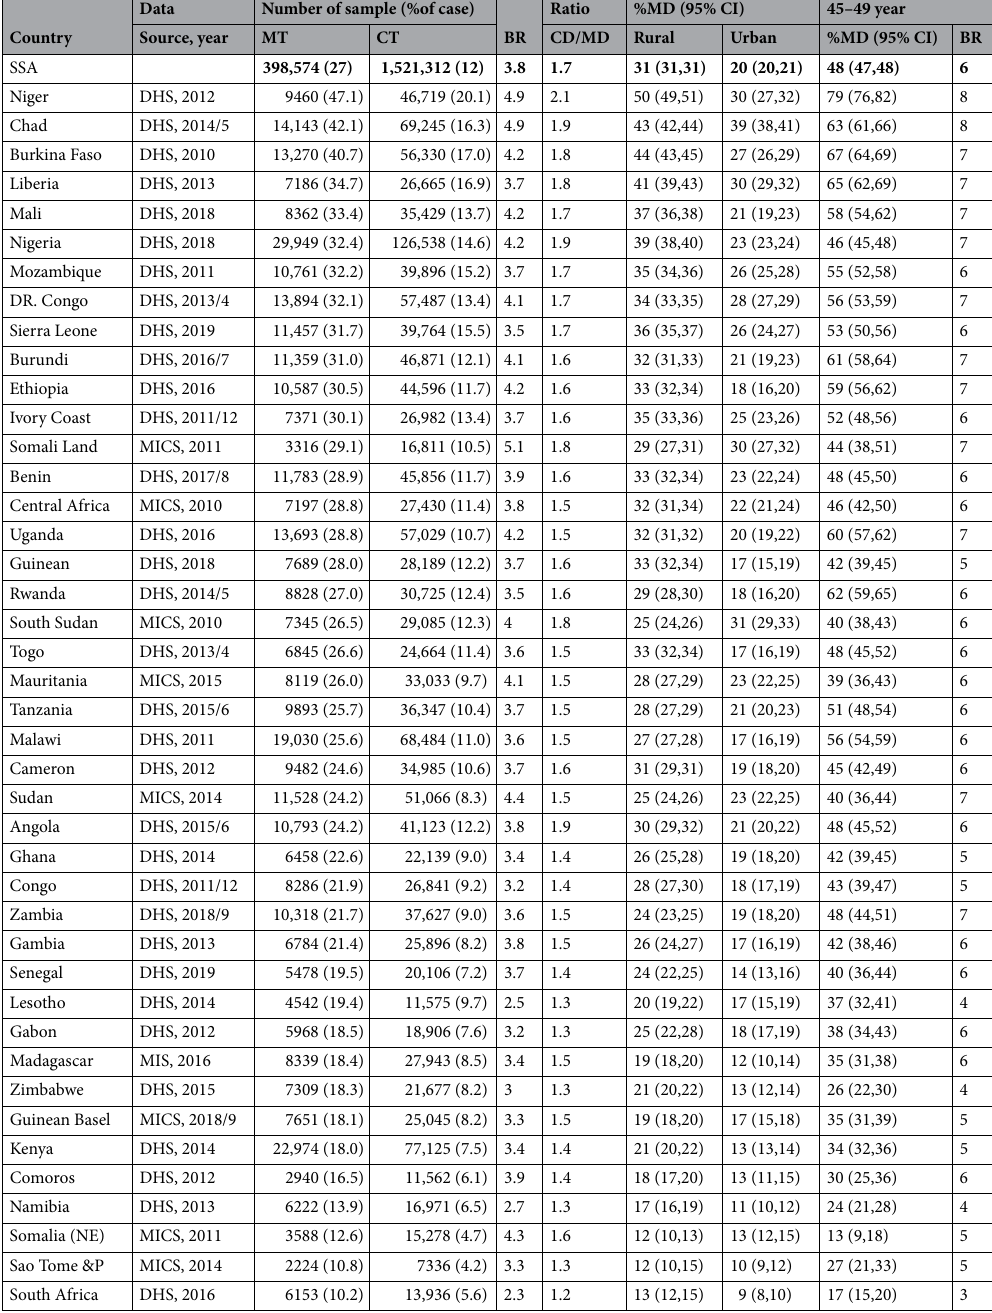
Table 1. Spatial distribution of sample size case prevalence, birth rate, ratio, residence and older age in child death and mother suffering of child death. MD the number of mothers who are suffering child death, MT